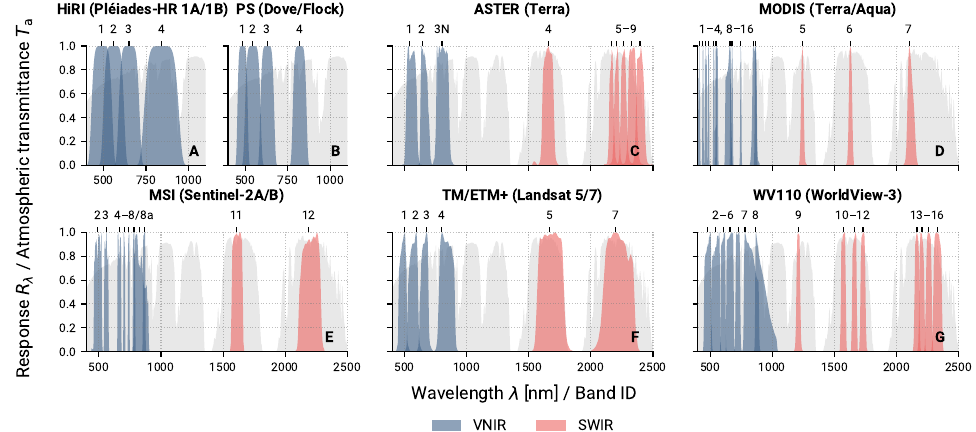
Figure A3. SRFs of multispectral sensors selected for simulations. As Pléiades ( A ) and PlanetScope ( B ) do not have channels in the SWIR, only their VNIR channels are shown. The SRFs of ( A , B ) were approximated using Equation (2), given their central wavelength and FWHM, which were all above 10nm. For ( C – G ), published SRFs were used. ( D ) MODIS channels 1–4 and 6–18 are very close together but do not have their central wavelengths in ascending order. The VNIR/SWIR threshold is at 1100 nm. SRFs of hyperspectral sensors used for simulations, i.e., EnMAP, Hyperion, and PRISMA are not shown due to their narrow SSIs. Earth’s transmission spectrum using MODTRAN is shown in gray [34].